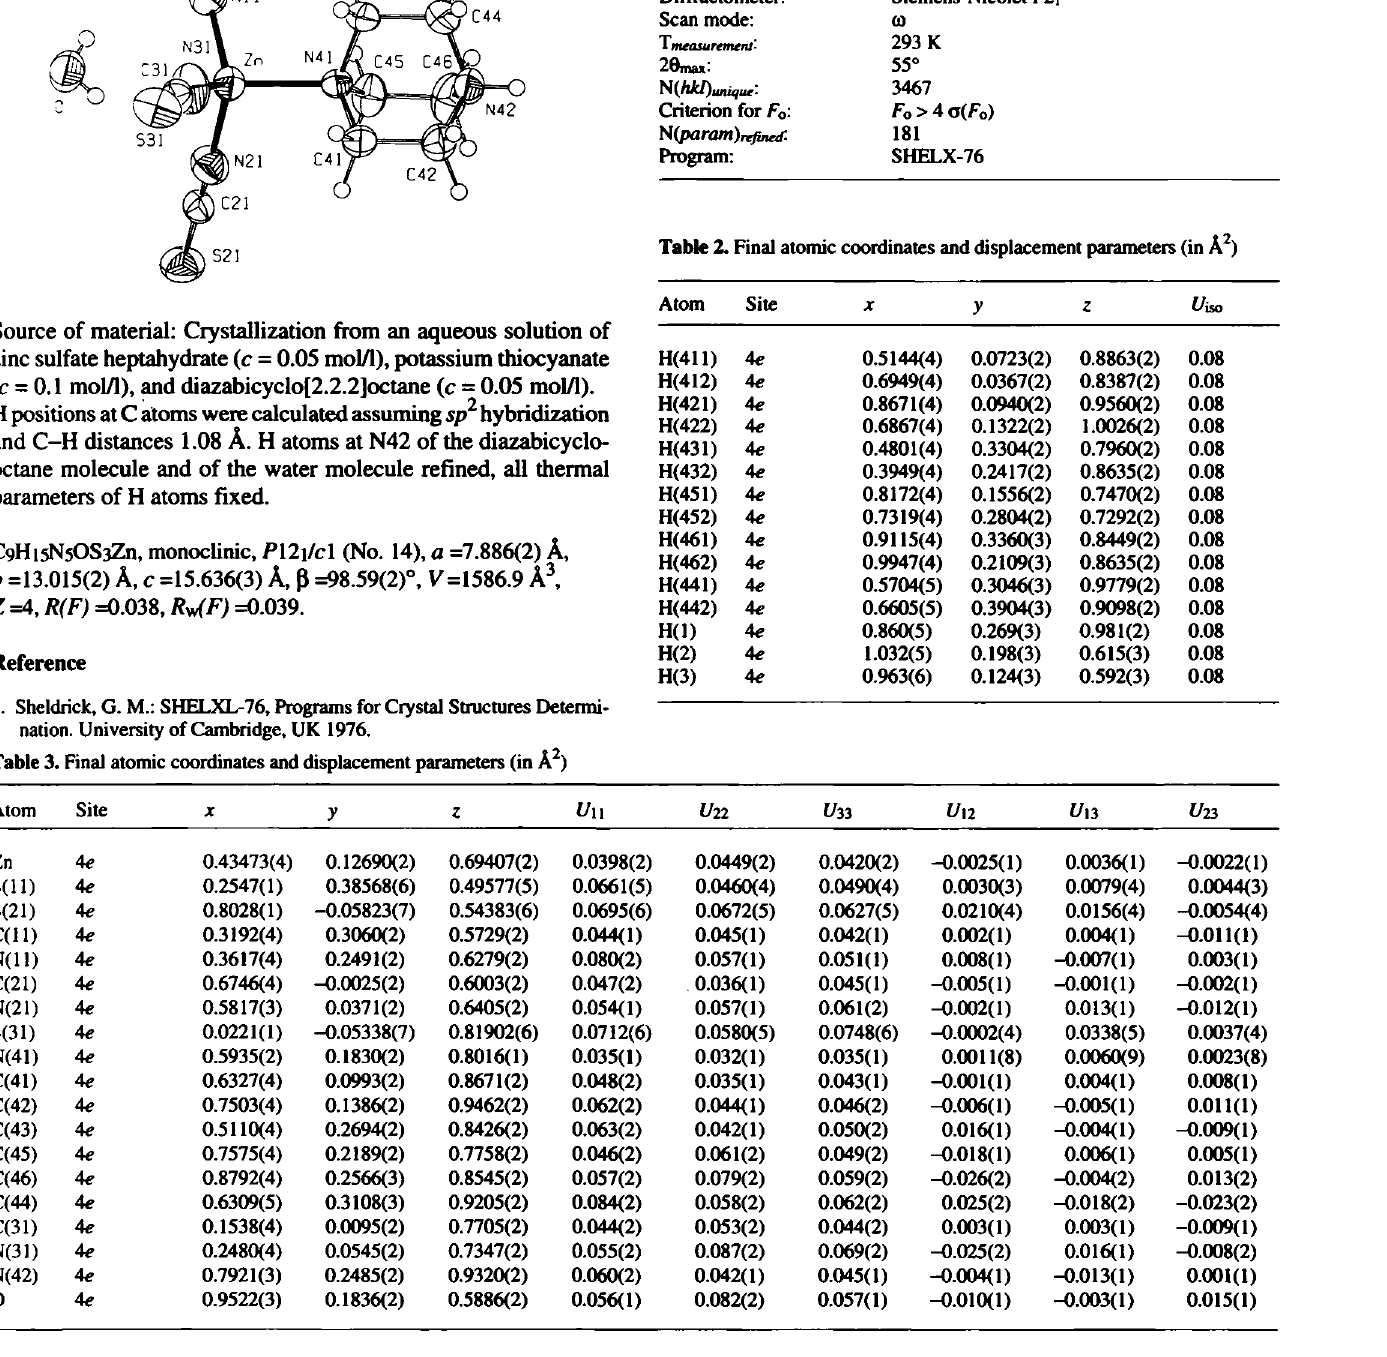
Table 1. Parameters used for the X-ray data collection Crystal: